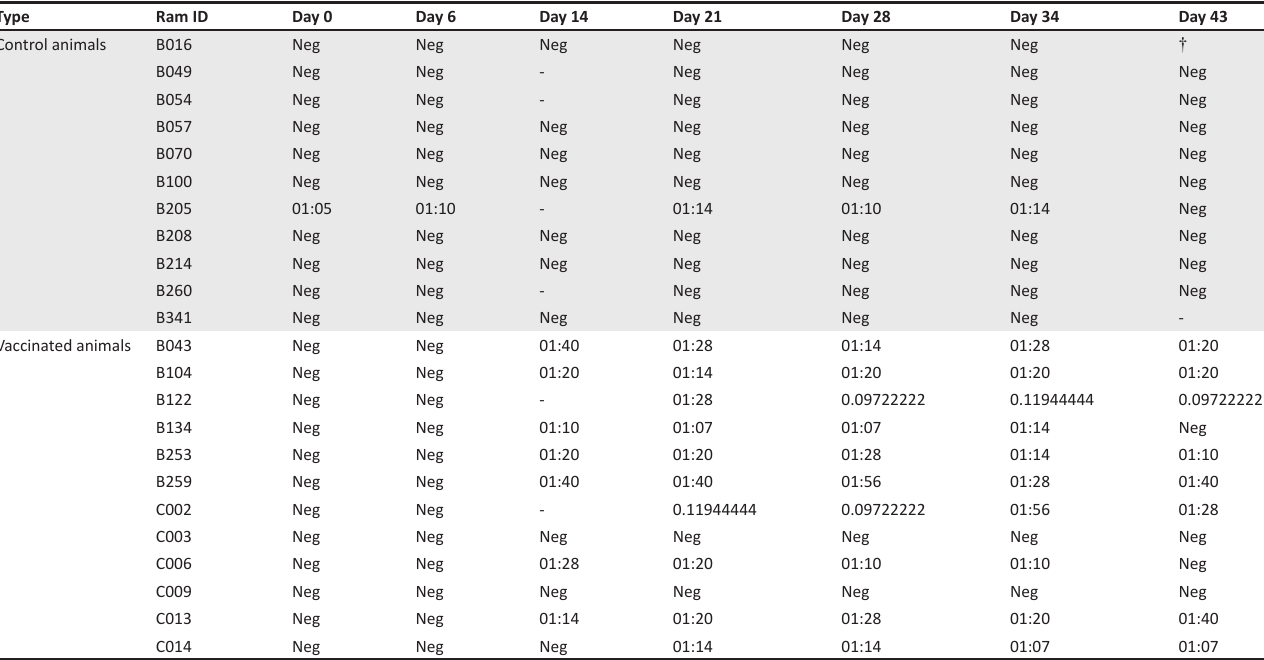
TABLE 1: Summary of serum neutralisation test results. Type